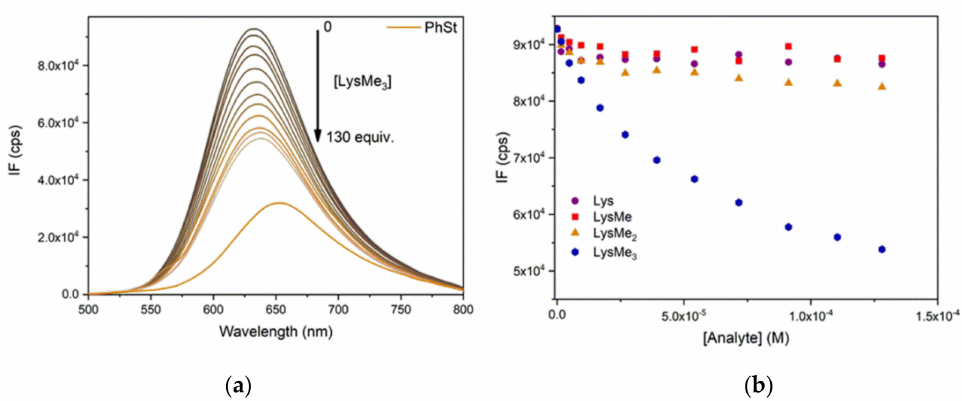
Figure 12. ( a) Fluorescence spectra of PhSt-CB7 assay ([PhSt] 0 = [CB7] 0 = 1.0 × 10 − 6 M) in pH 8.0 bu ff ers in the presence of 0–130 equiv. LysMe 3 ; ( b ) Fluorescence intensities of the assay at 632